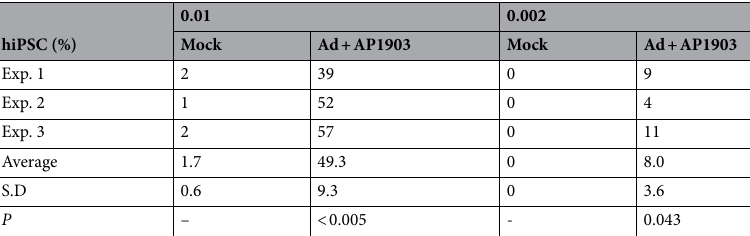
Table 2. Number of detected hiPSCs in the three independent experiments shown in Fig. 6. The number of hiPSCs per 20,000 cells in gates 1 and 2 is shown. The average and SD were calculated from the data of three independent experiments. The P values (one tailed) were analyzed by two-way repeated measures ANOVA and SNK post-hoc test ( vs. mock of the same hiPSC concentration, SigmaPlot Version 12.5).